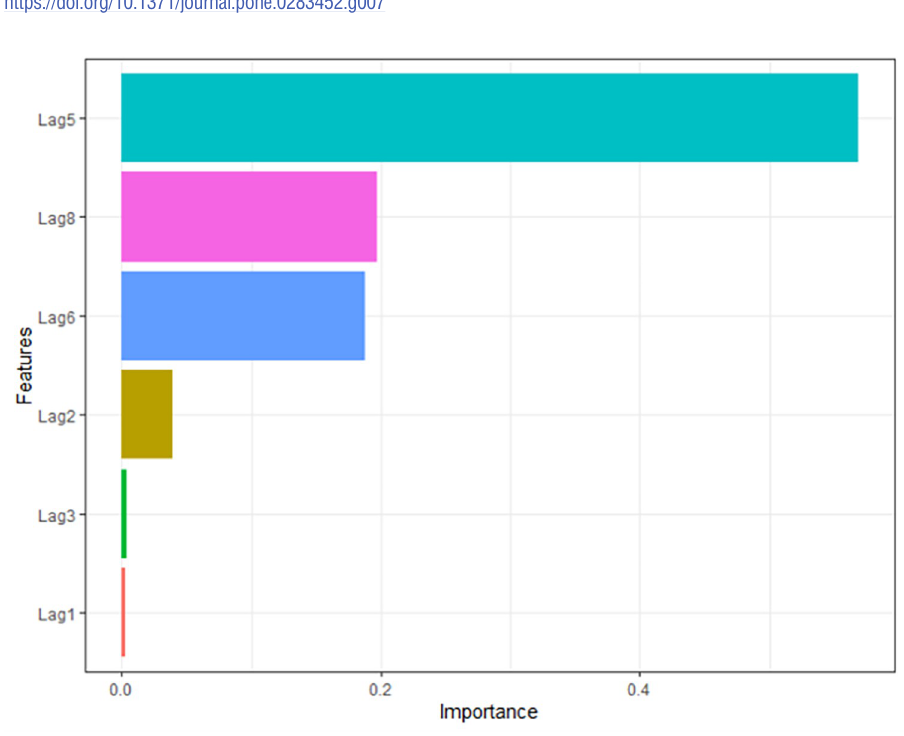
Fig 8. Important characteristic features of the XGBoost